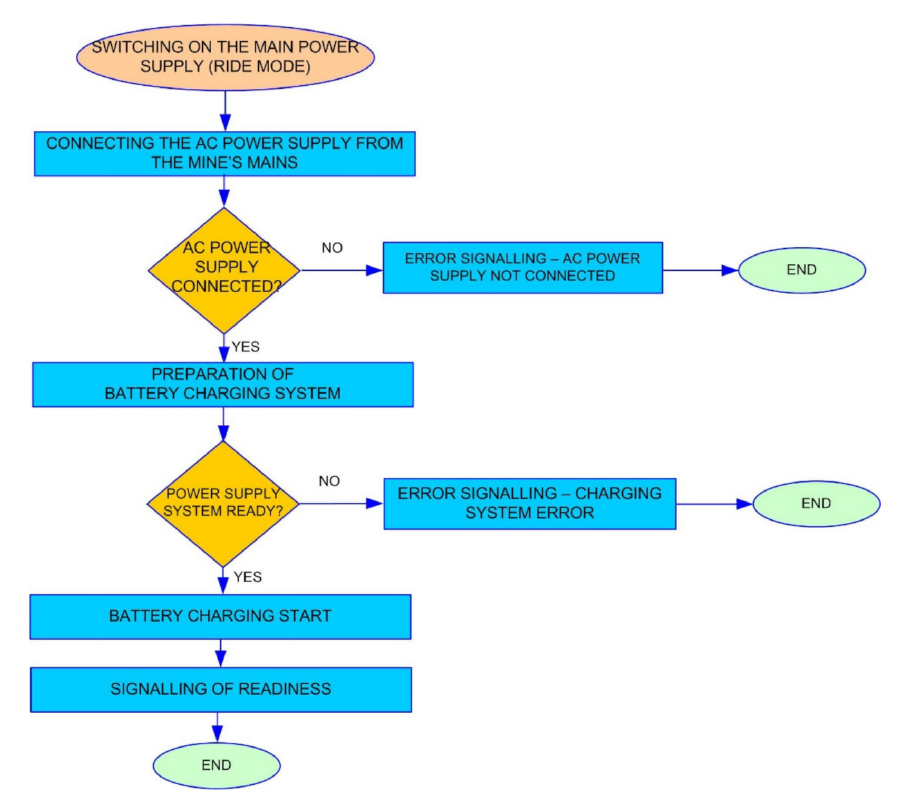
Figure 7. Algorithm for the procedure of switching on the supply voltage in the operating